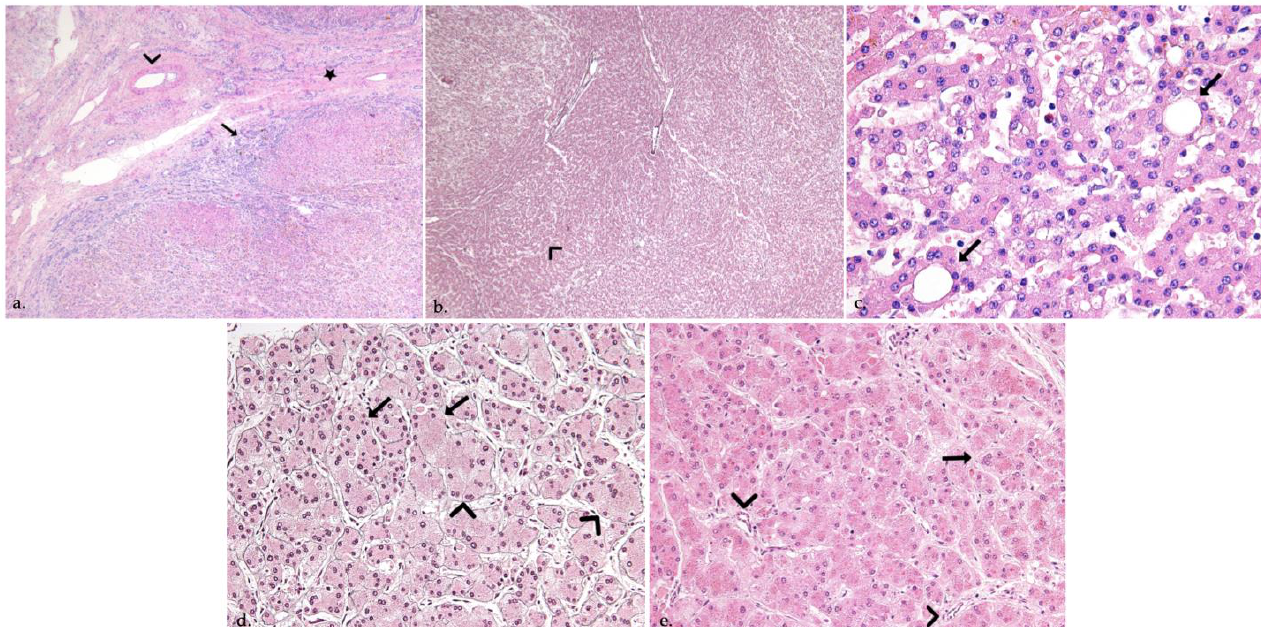
Figure 4. ( a ) Focal nodular hyperplasia in a 13-month-old girl. Histology shows benign hepatocellular nodules separated by thick fibrous septa (star) radiating from the central scar, containing thick-walled abnormal-appearing arteries (arrowhead) and a ductular reaction (arrow) (Hematoxylin & Eosin, H&E, original magnification × 40). ( b , c ) High-grade dysplastic nodule in a female patient aged 3 years and 5 months at transplantation, reticulin stain (5b, × 40) highlights a vaguely “nodular within nodule” growth (arrowhead), and increased cell density, while H&E stain (5c, × 400) shows small cell changes (arrowhead) and pseudoglands (arrows). ( d , e ) Well-differentiated hepatocellular carcinoma in a 1-year-old girl. Plate thickening (arrowheads) and focal loss of reticulin staining (arrows) is seen, together with variation in tumor cell size, multinucleation (arrow) and several unpaired arteries (arrowheads) (5d, reticulin stain, 5e, H&E, × 400). Table 2. Histo-pathological characteristics of nodules identified in liver explants. * One nodule can overlap multiple liver segments. ** Largest diameter for every nodule, median (range) diameter for every nodule type . KPE, Kasai hepatoportoenterostomy; LT, liver transplantation. Nodules Nodule